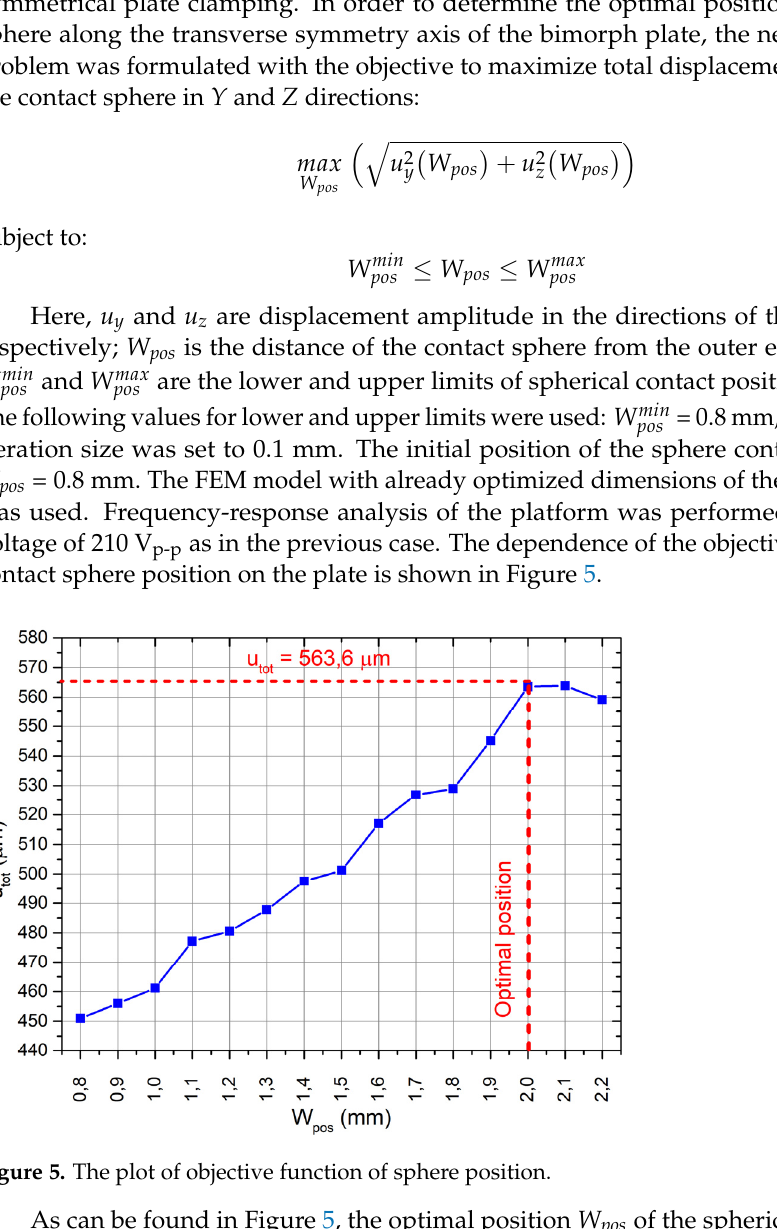
Table 4. Summary of the results from optimization problems. L Plate , mm